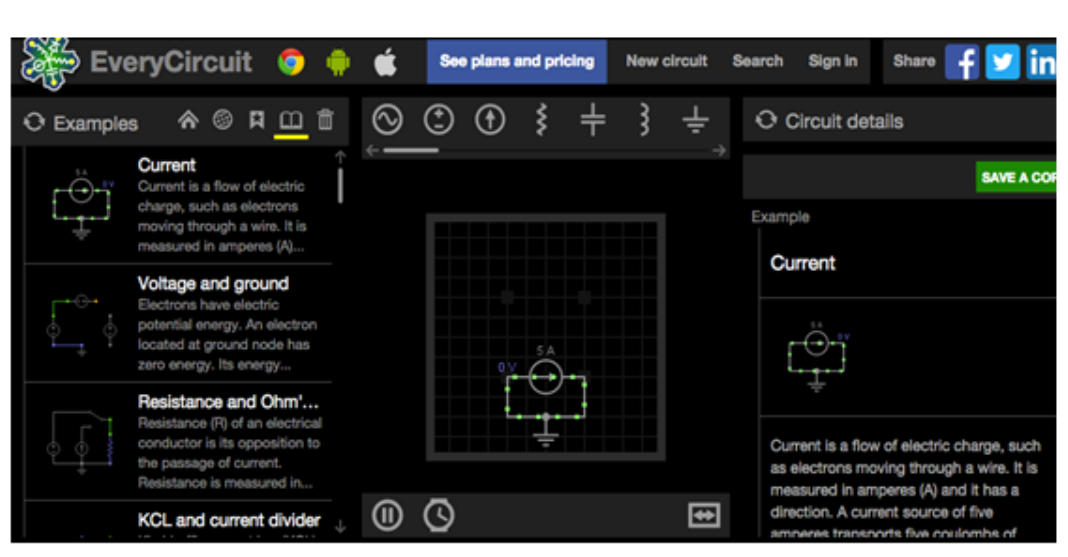
Figure 1. The Every Circuit home page for the online module used by the